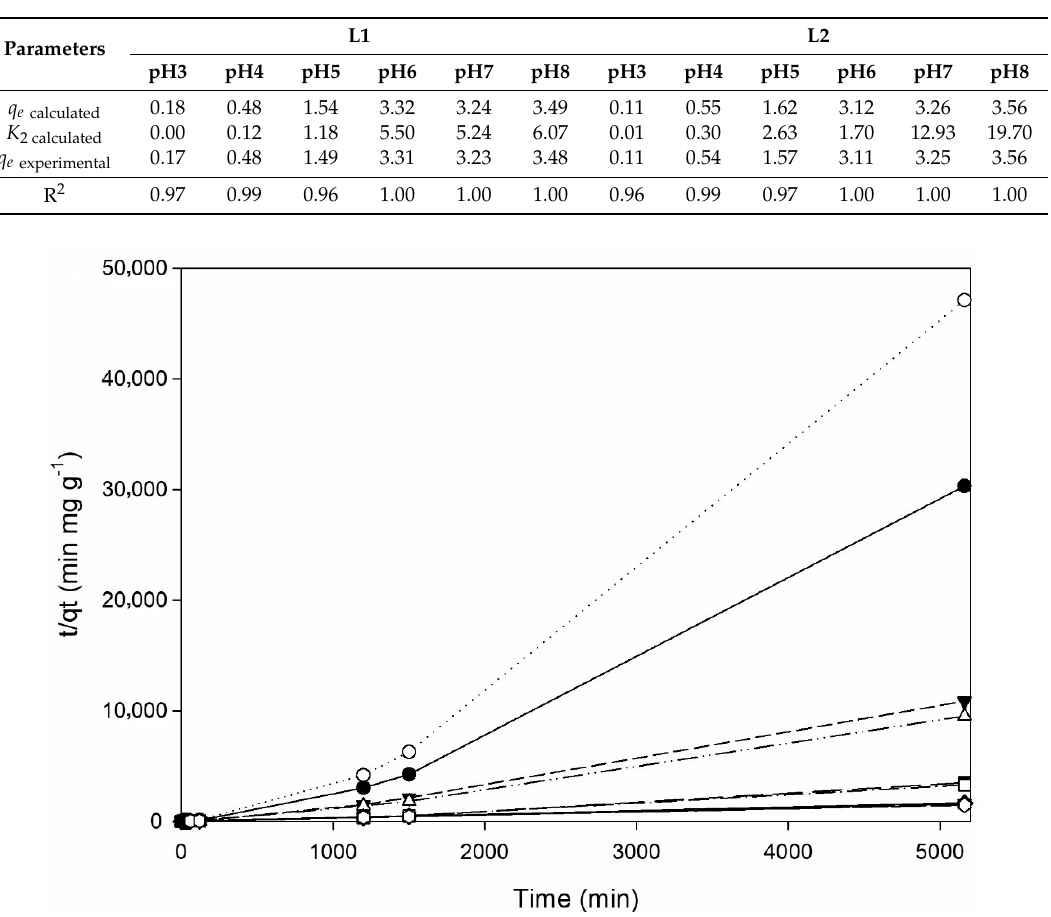
Table 1. Langmuir Isotherm data for the two types of substrates. L1 L2 Isotherm Parameters Values Isotherm Parameters Values Q m (mg g -1 )